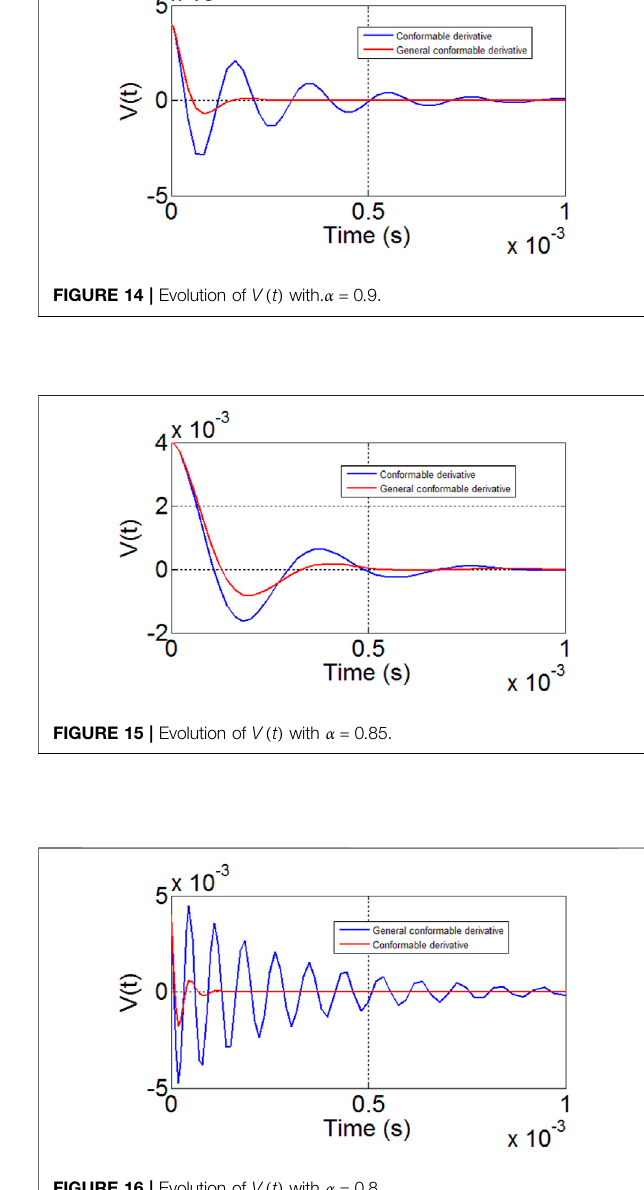
FIGURE 16 | Evolution of V ( t ) with α (cid:2) 0 .